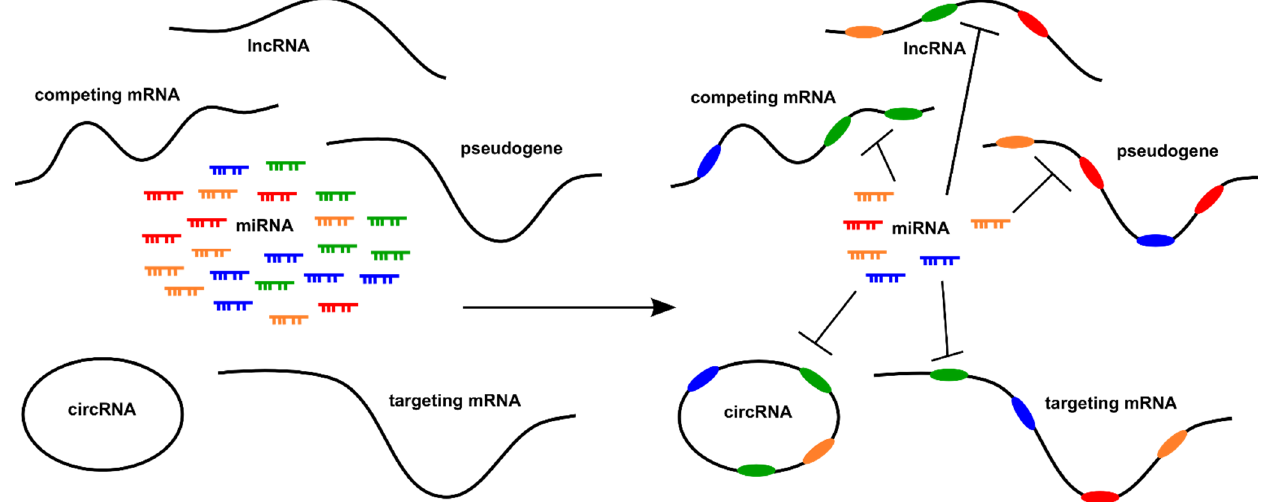
Figure 2. Network of competing endogenous RNAs (ceRNAs). MicroRNAs bind to miRNA response elements (MREs) that are in the transcriptome of different classes of RNA transcripts, namely circRNAs, lncRNAs, pseudogenes, and protein-coding mRNA. All classes of RNA transcripts contain MREs and compete for miRNA binding, thereby regulating the common pool of miRNA. All represented classes carrying the same MRE interact with each other through competition for the same miRNA (adapted from [40]).